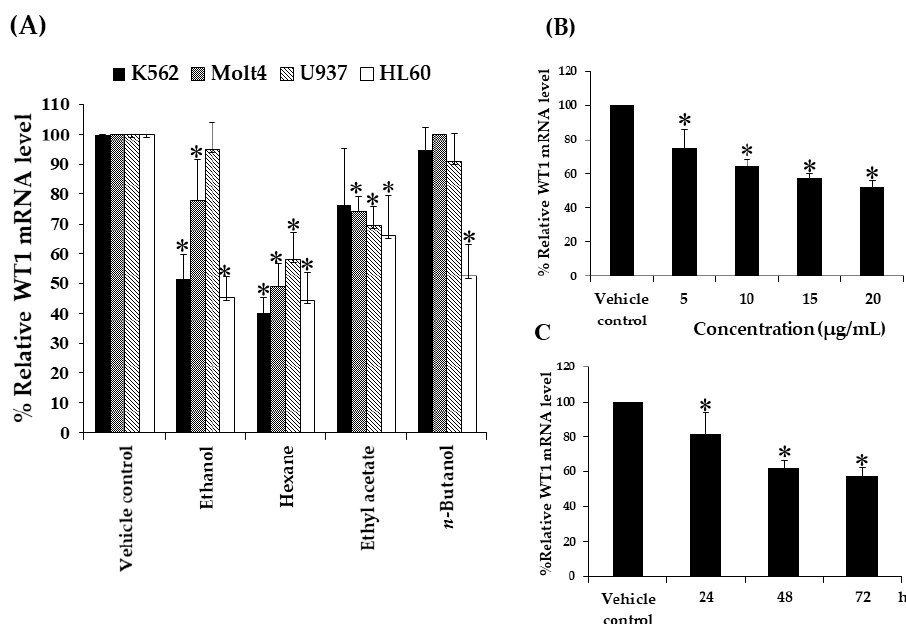
Figure 2. Effects of kaffir lime leaf extracts at IC 20 on Wilms’ tumor 1 (WT1) mRNA levels in K562, Molt4, U937, and HL60 cells at a density of 1.0 × 10 5 cells/mL. The cells treated for 2 days in ( A ) complete Roswell Park Memorial Institute (RPMI)-1640 medium, ( B ) the medium with 5, 10, 15, and 20 µg/mL of hexane extract, 0.08% DMSO was used as vehicle control. ( C ) The cells treated for 24, 48, and 72 h, 0.05% with 13.6 µg/mL of hexane extract, DMSO treated for 3 days was used as vehicle control. WT1 mRNA was determined using real-time PCR and presented as %WT1 mRNA levels. The expression levels of WT1 mRNA were normalized using the expression of β -actin mRNA as the internal control. Data are expressed as mean ± SD of three independent experiments. Asterisk (*) demonstrates statistically significant difference between the values of the vehicle control and the sample ( p < 0.05).